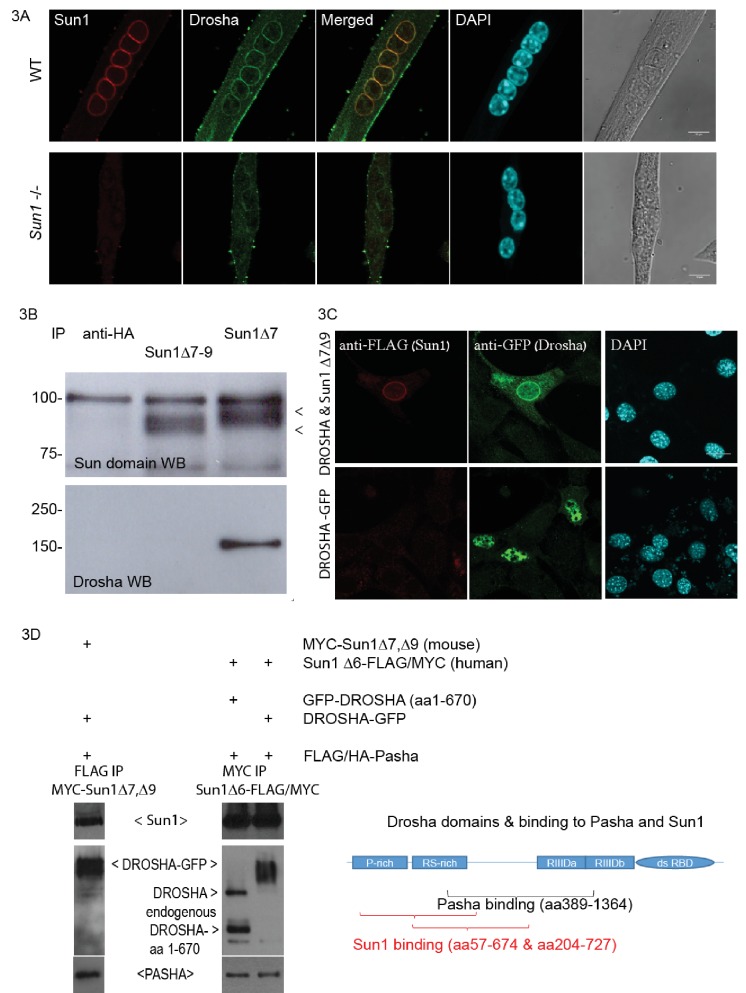
Sun1 interacts with Drosha.(A) Confocal images of Drosha and SUN1 isoforms (12.10F antibody recognizing all SUN1 isoforms) localized to the NE of WT myotube nuclei, but not in the Sun1–/– myotubes. (B) Immuno-precipitation of SUN1 isoforms from C2C12 myotubes with two SUN1 antibodies (Δ7 and Δ7–9). SUN1 immuno-precipitates were detected with an anti-SUN domain antibody. Drosha was co-precipitated with SUN1 Δ7, but not with the Sun1 Δ7–9 isoform or anti-HA control antibodies. (C) Transient transfection of tagged cDNAs of Drosha and SUN1 Δ7 isoform in NIH3T3 cells, reveals enriched GFP tagged Drosha to the NE in nuclei co-expressing FLAG tagged SUN1 Δ7, Δ9 (top panel). Drosha expression in the absence of SUN1 Δ7,Δ9 localized throughout the nucleoplasm (bottom panel). (D) Transient transfection of tagged cDNAs in HEK293 cells for co-immuno-precipitation analysis. The Drosha schematic diagram shows the proline rich-, arginine/serine rich domains, the catalytic domains (RIIID) and RNA binding domain. The Pasha- and Sun1 binding domains partially overlap.